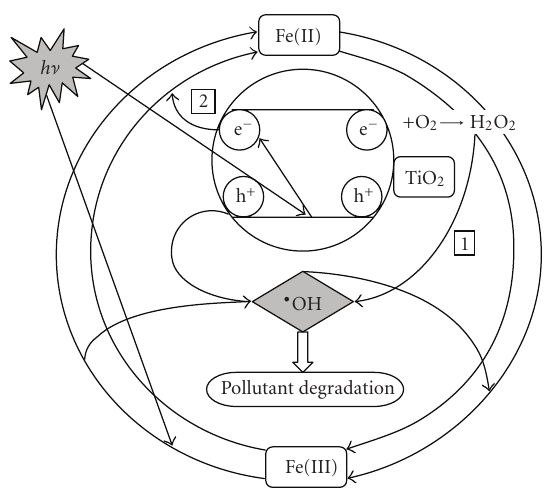
Figure 13: Photochemical cycle of combined system iron-TiO 2